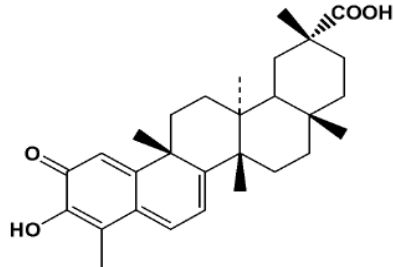
Figure 1. Chemical structure of